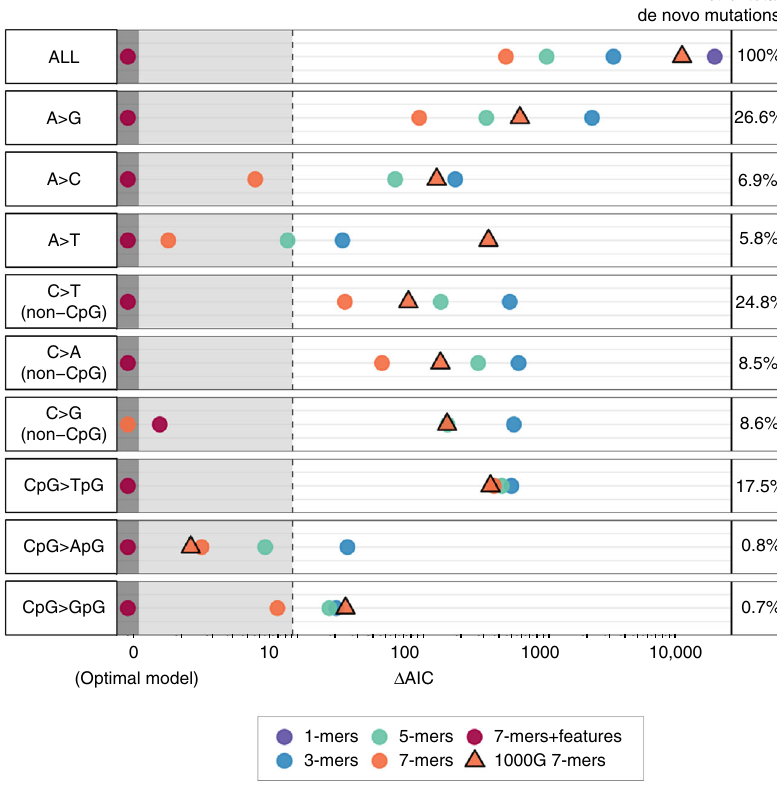
Fig. 4 Comparison of goodness-of- fi t for different mutation rate estimation strategies. For each mutation type and each model i , we calculated Δ AIC i ¼ AIC i (cid:2) AIC min as a measure of relative model performance, with lower values of Δ AIC indicating better fi t to the GoNL/ITMI de novo mutation data. Δ AIC is shown on the horizontal axis on an arcsinh scale. For each mutation type, the best- fi tting model thus has a Δ AIC = 0. Models with Δ AIC < 10 (grey- shaded area) are considered comparable to the optimal model, whereas models with Δ AIC > 10 are considered to explain substantially less variation